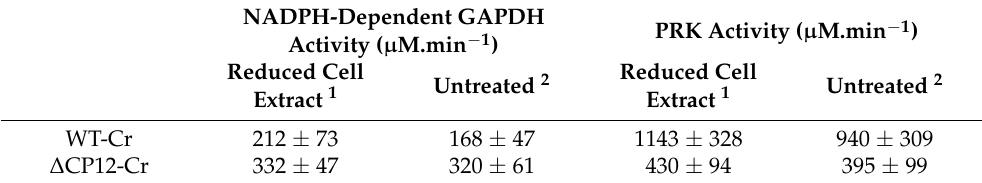
Table 1. NADPH-dependent GAPDH and PRK activity per mg of total proteins in cell extracts treated with a reducing agent and in untreated cell extracts of ∆ CP12-Cr and WT-Cr strains. Standard deviation of three biological replicates is indicated except for GAPDH activity in reduced cell extracts for which standard deviation of three biological replicates plus two technical replicates are indicated. The total protein amount in the PRK activity assays ranged from 27 to 60 µg WT-Cr cell extracts and from 9 to 35 µg Δ CP12-Cr cell extracts. The total protein amount in the GAPDH activity assays ranged from 54 to 120 µg for WT-Cr cell extracts and from 18 to 70 µg for Δ CP12-Cr cell extracts. NADPH-Dependent GAPDH Activity ( µ M.min − 1 ) PRK Activity ( µM.min − 1 ) Untreated Reduced Cell Extract 1